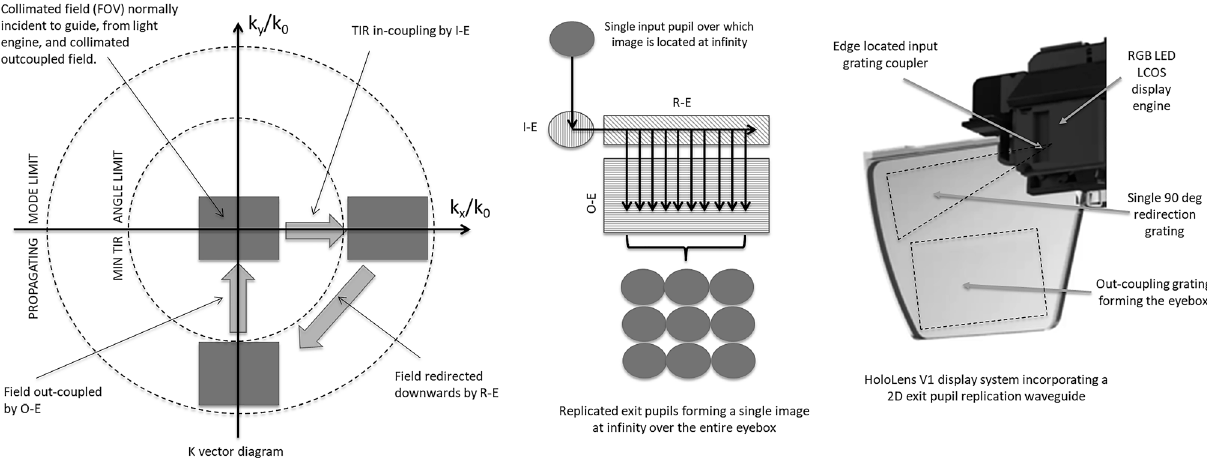
Figure 28: k -vector diagram and lateral pupil replication layout for a single guide and single